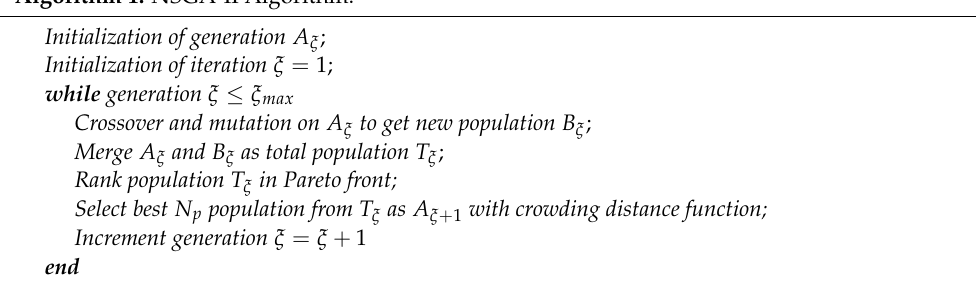
Algorithm 1: NSGA-II